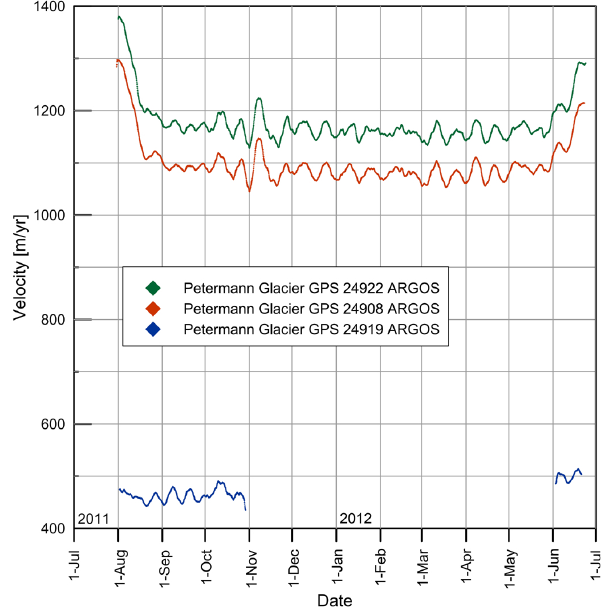
Figure 10. Petermann Glacier 7-day averaged GPS velocities (see Fig. 1 and Table 1 for instrument position and operational